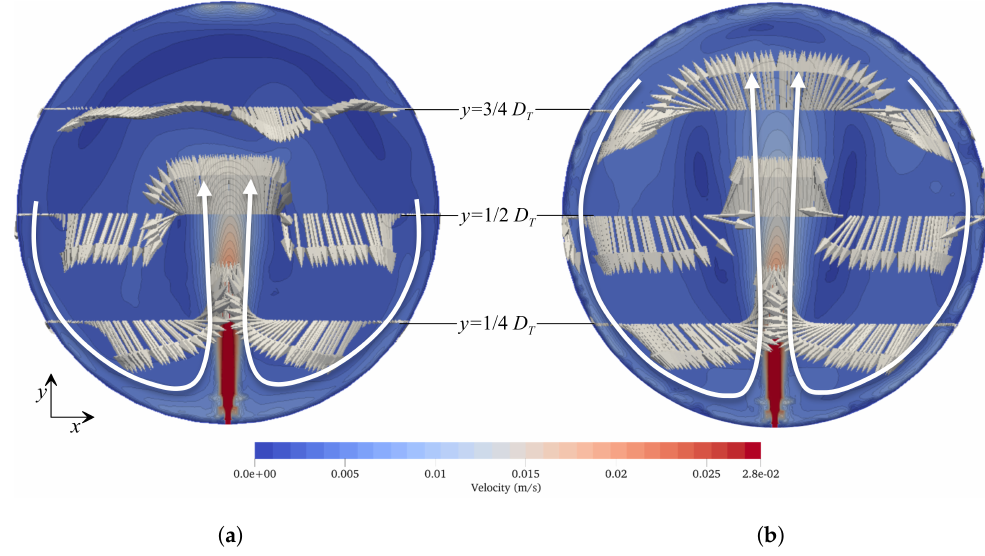
Figure 9. Plunging jet: velocity vectors and contours at z = 0.5 H at ( a ) 50 s; and ( b ) 150 s.